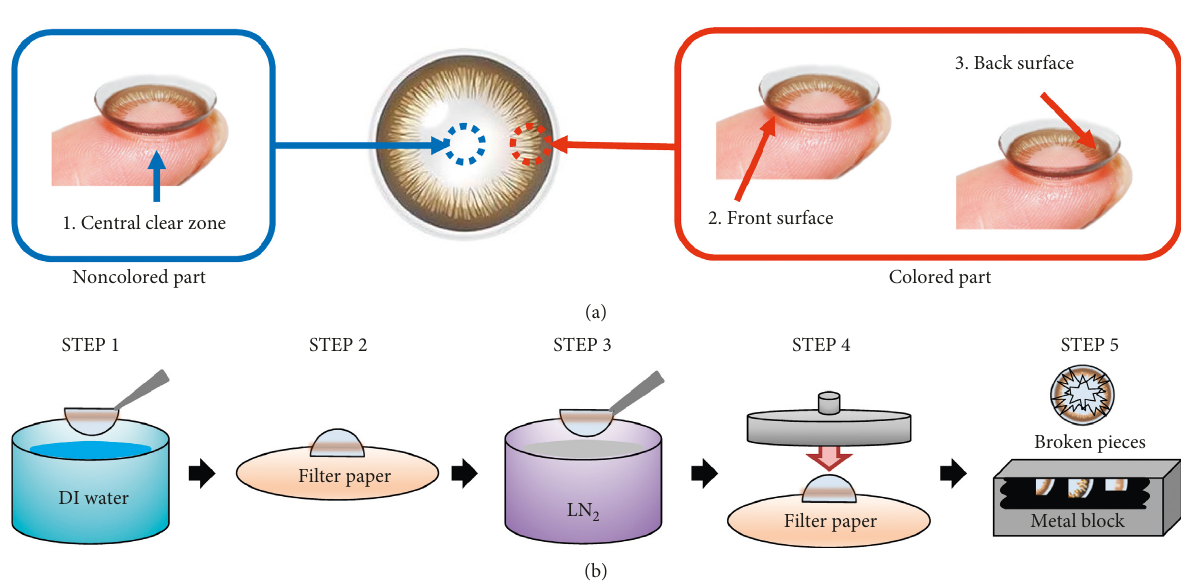
Figure 1: Schematic drawing of (a) analysis area of a cosmetic lens and (b) preparation procedure of a cross-sectioned